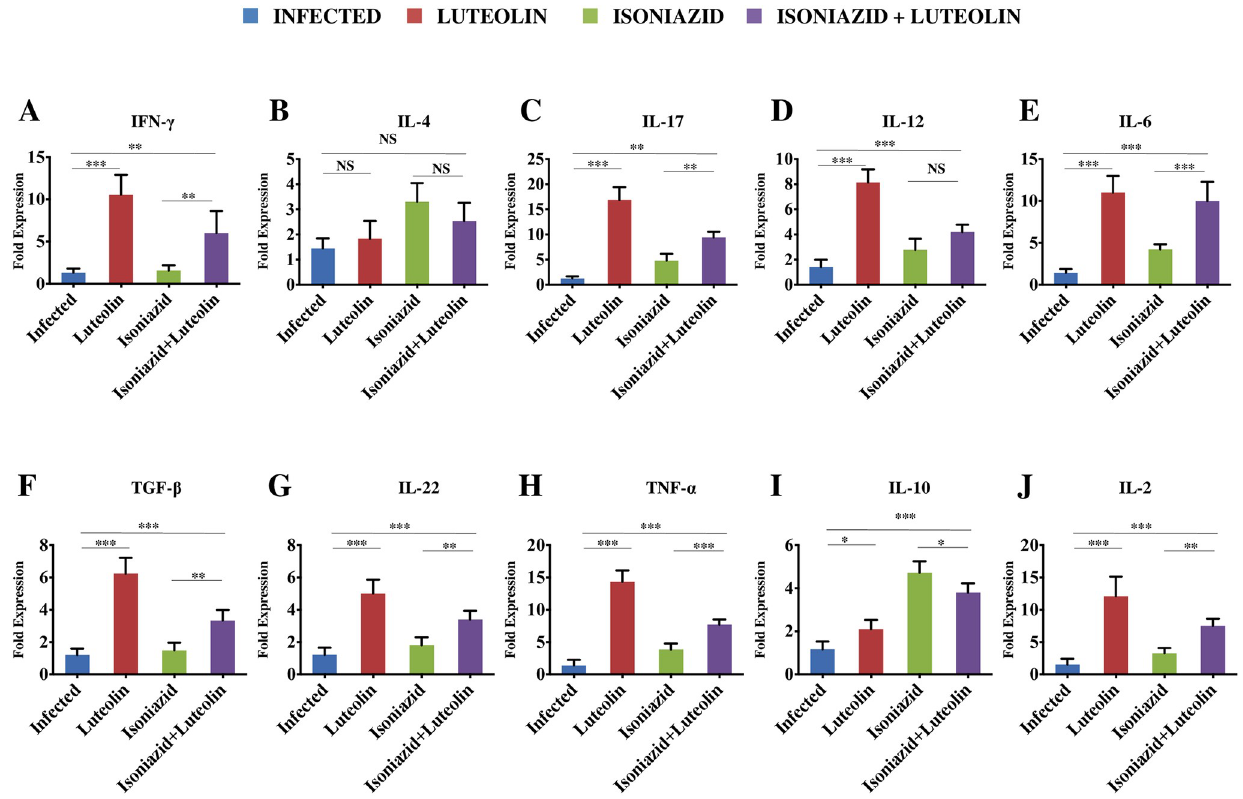
Fig 5. Expression of pro- and anti-inflammatory cytokines in the lungs of infected animals. The lungs from infected and treated mice were macerated and ex-vivo stimulated with M . tb complete soluble antigen for 24 h followed by RNA extraction and RT-PCR analysis (see Materials and methods). Bar graphs represent the fold change in the expression of (A ) IFN- γ , (B) IL-4, (C) IL-17, (D) IL-12, (E) IL-6, (F) TGF- β , (G) IL-22, (H) TNF- α , (I) IL-10 and (J) IL-2 in various groups of mice as compared to the control infected mice. Data represents 5 mice per group (Mean ± SD, n = 5). � p < 0.05, �� p < 0.005, ��� p <